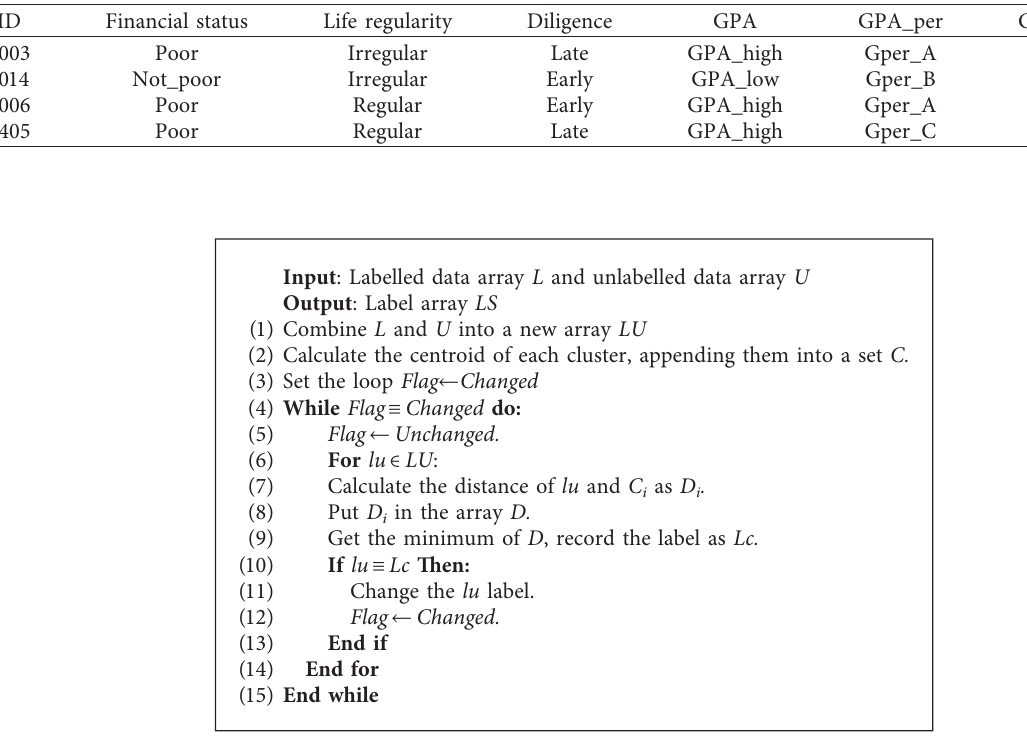
Table 7: The input data format of Algorithm